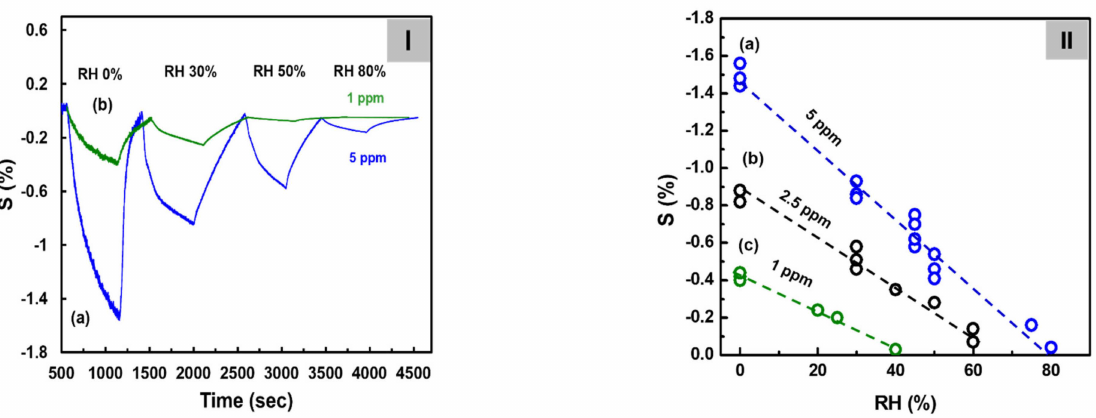
Figure 6. ( I ) The continuous dynamic response of the C8F 0.1 -doped-PPy/PLA 0.5 @SWCNT sensor to different humidity conditions with C 3 H 6 O gas at 5 ppm at 25 ◦ C. ( II ) Sensitivity change with increasing humidity measured at each gas concentration: ( a ) 5 ppm, ( b ) 2.5 ppm, and ( c ) 1